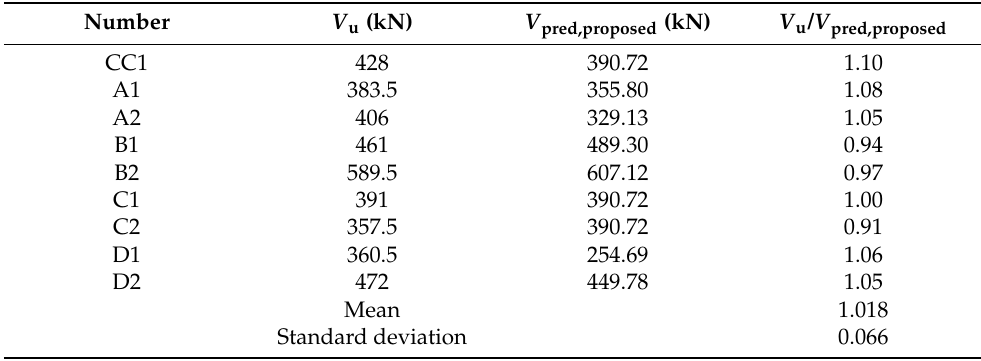
Table 7. Validation results of the proposed